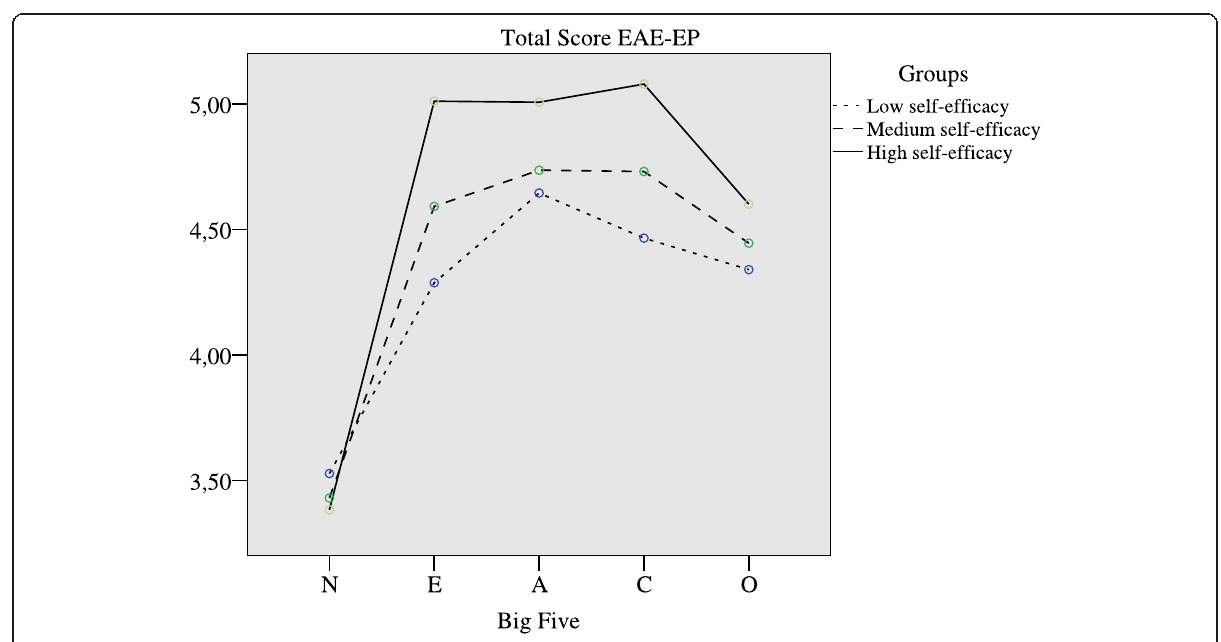
Fig. 1 Personality profile for different levels of EAE-EP total